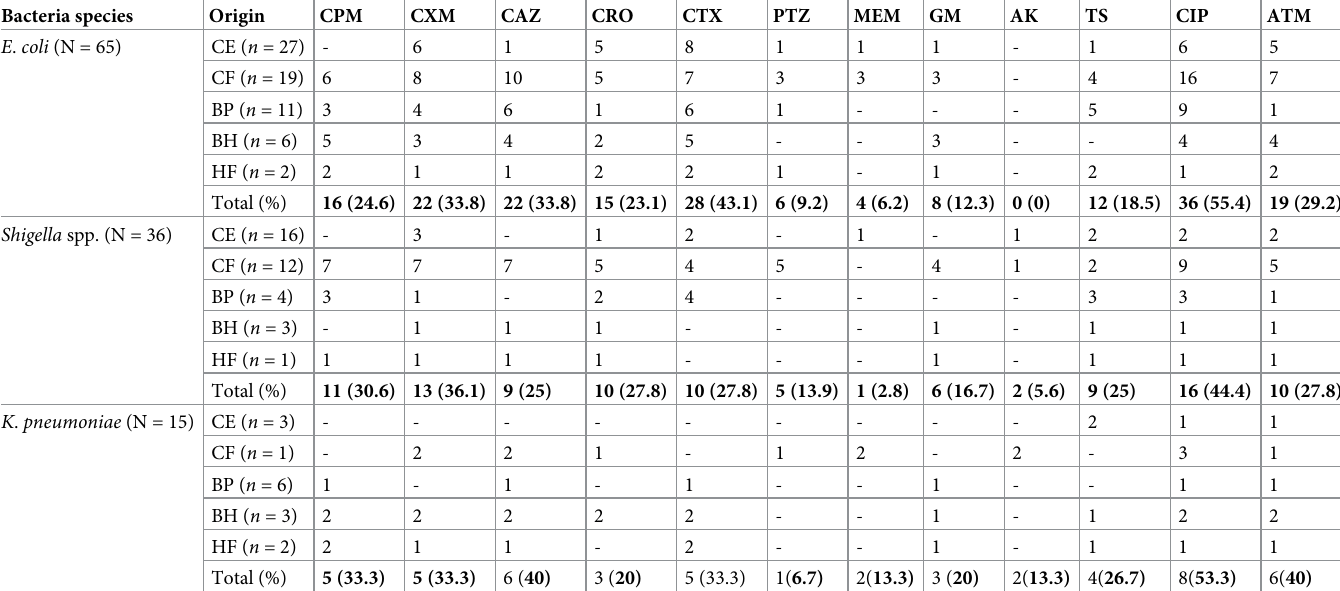
Table 3. Number and proportion of antibiotic-resistant Enterobacteriaceae strains. Bacteria species